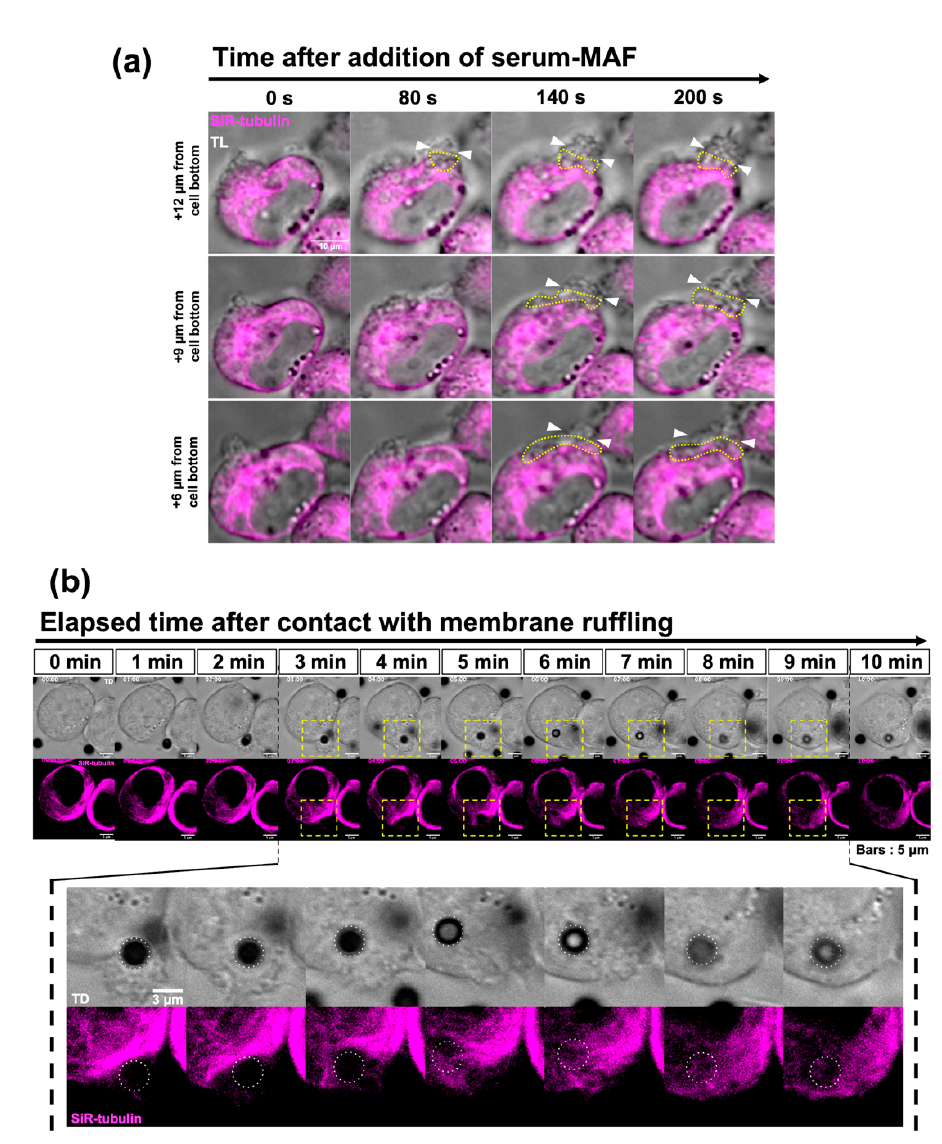
Figure 3. Effects of serum-MAF on phagocytosis and microtubules. ( a ) Changes in the microtubules just after serum-MAF activation was recorded with SiR-tubulin-stained macrophage. Merged images of SiR-tubulin (magenta) and transmitted light (grey scale) of different Z-positions of the optical sections (+6, +9, and +12 µm from the cell bottom) at indicated times (0, 80, 140, and 200 s after the addition of serum-MAF) are shown. The root of membrane extrusion is indicated by two arrowheads. The microtubule-free region of the cytoplasm was encircled by a dotted line. Membrane extrusion was very dynamic. The membrane extrusion indicated in this figure was expanded from the upper region (+12 µm 80 s) to the lower region (+6 µm 200 s). According to this expansion, microtubule staining in the cytoplasm became faint underneath the membrane extrusion. ( b ) Time-lapse images showing pseudopod extrusion (Upper; TL) and microtubules (lower; SiR-tubulin) during bead internalization. The time after the focused bead (encircled by dotted line) attached to the elongated membrane ruffling are indicated. Enlarged images indicated in broken rectangles are shown. Scale bars: 10 µm or 3 µm as indicated.